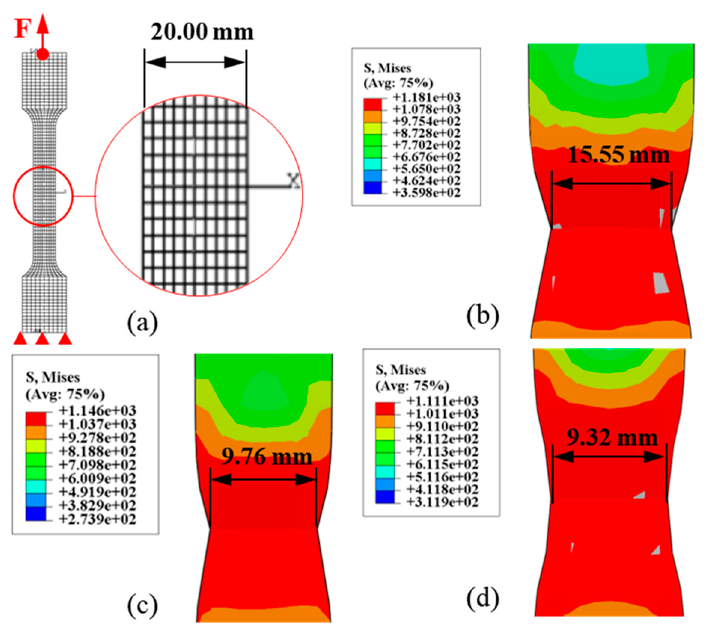
Figure 7. ( a ) The FE model for all steels, and the necking situations of ( b ) V-alloyed, ( c ) Ti-alloyed, and ( d ) Nb-Ti-alloyed steels.